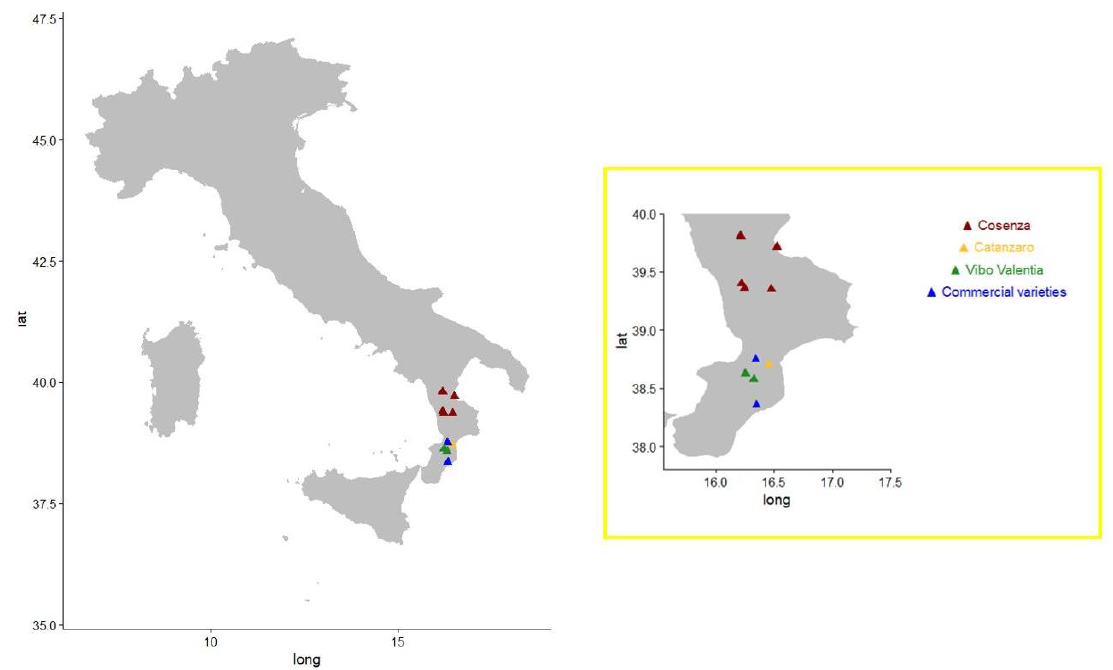
Figure 1. Geographical locations of wild hops (Red—Cosenza; Yellow—Catanzaro; Green—Vibo Valentia; blue—the commercial varieties Comet and Columbia in the province of Reggio Calabria, Fuggle and Hersbrucker in the province of Vibo Valentia). Table 1. List of the studied hops genotypes. Province Place Elevation (m a.s.l.)